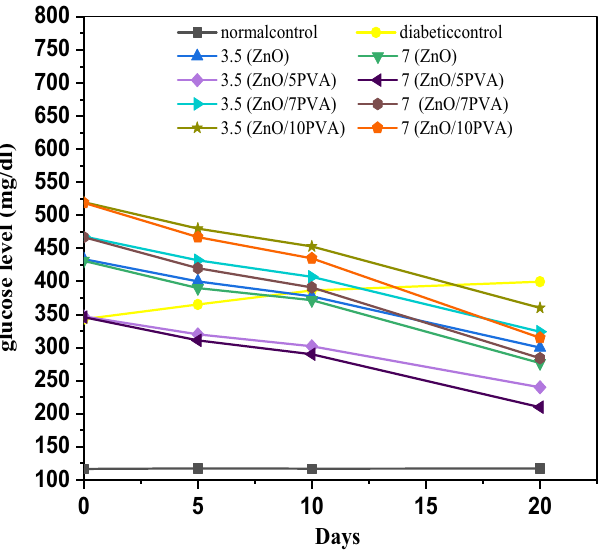
Figure 11. Glucose level against days for ZnO, ZnO/5PVA, ZnO/7PVA and ZnO/10PVA calcined at 300 °C for two series 3.5 mg and 7 mg.